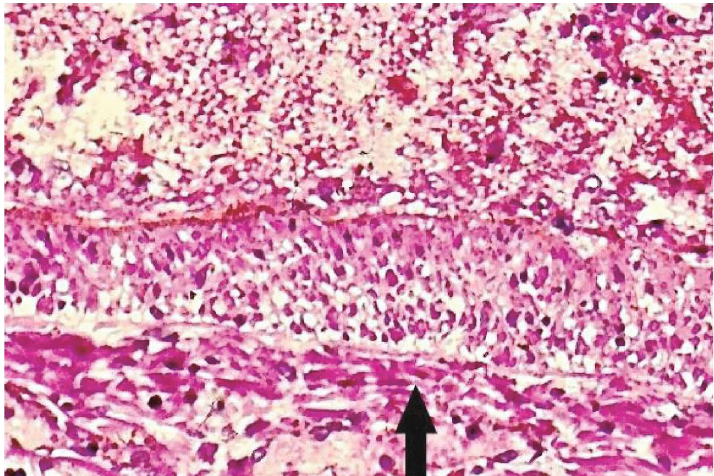
Figure 27: Pulmonary artery segmental arterial mediolysis injurious phase. The arrow points to a large focus of apoptosis involving the outer half of the media. Hematoxylin & eosin × 200 (adapted from Interventional Cardiology 12(3) copyright 2020, online